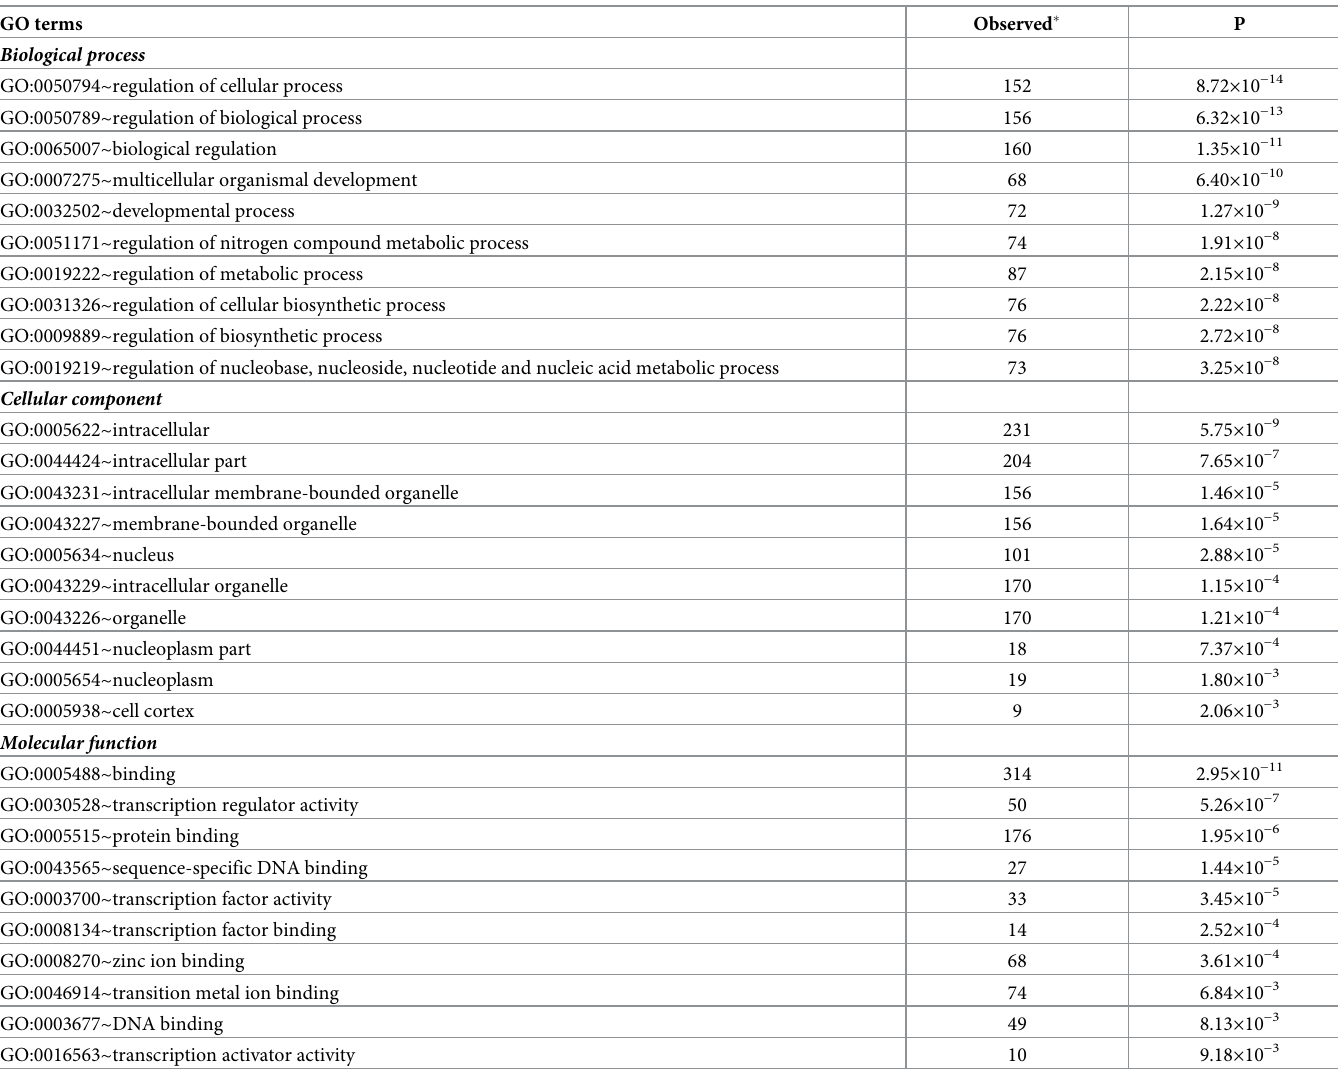
Table 2. The top Gene Ontology (GO) terms enriched with the targets of bta-mir-655 (P <